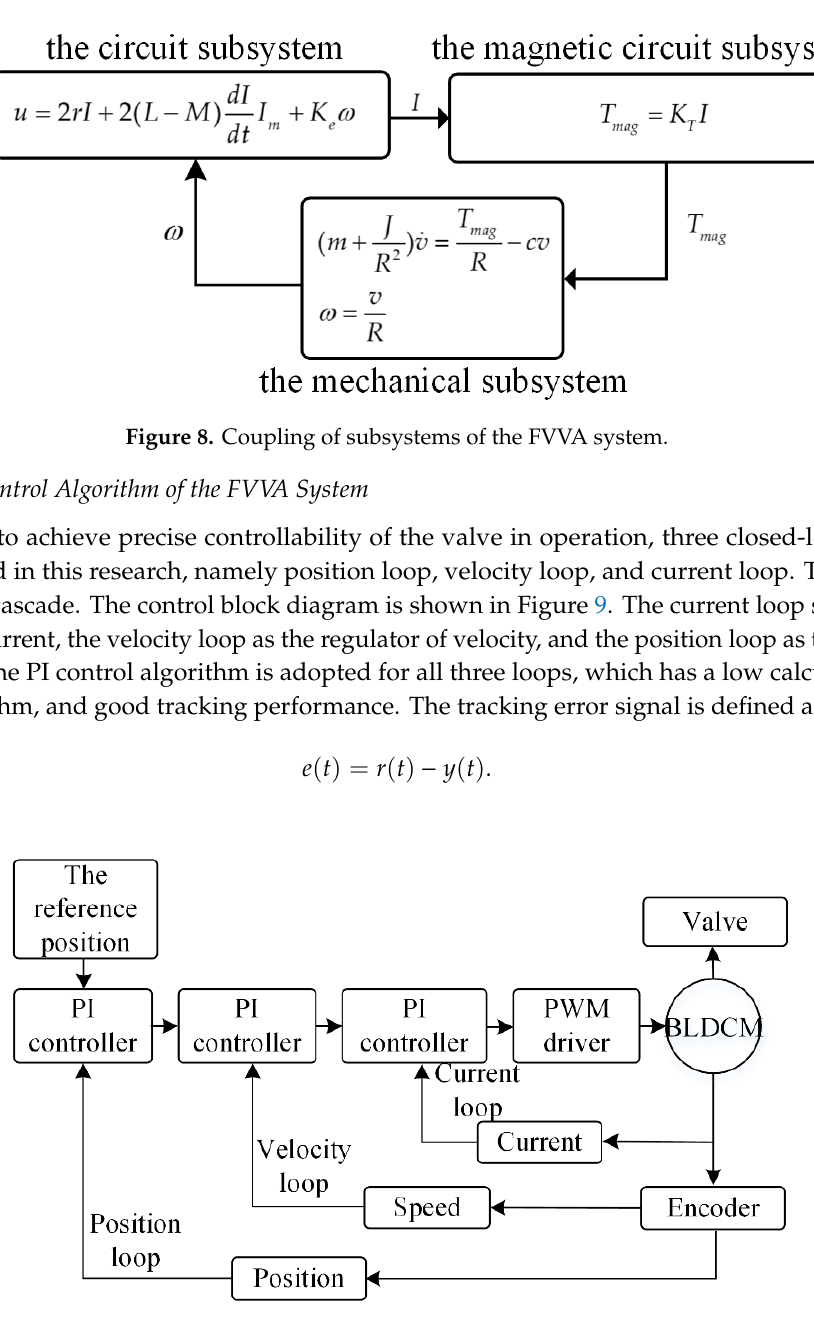
Figure 9. Three-loop control system for the FVVA system.